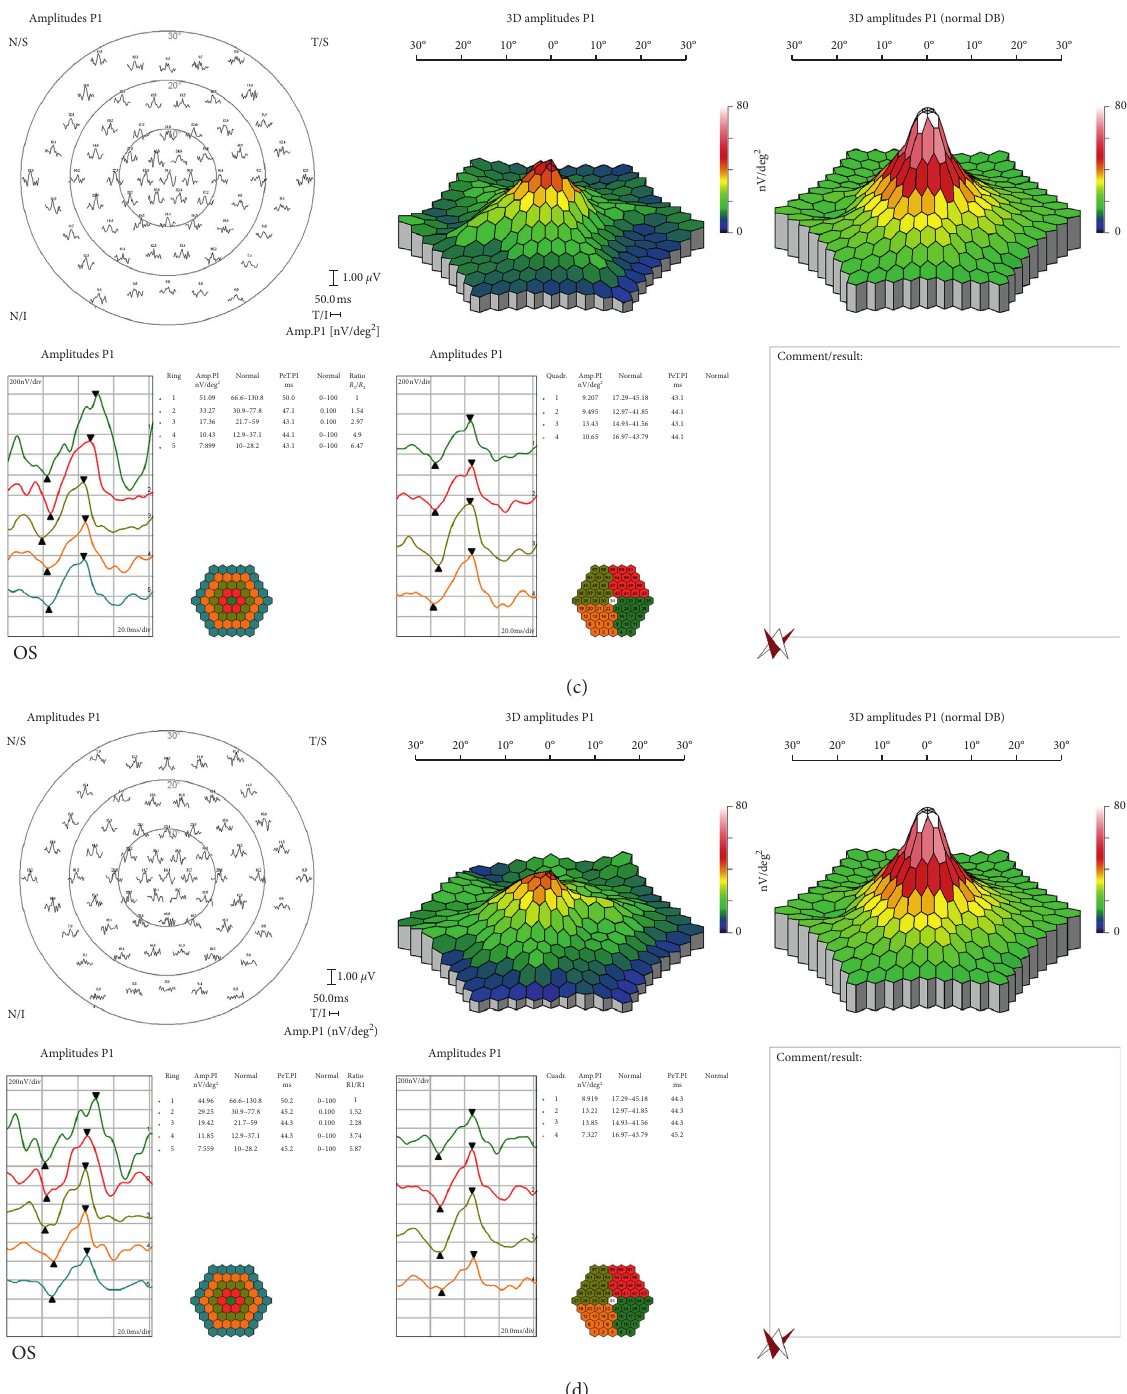
Figure 2: Multifocal electroretinography outcomes: (a) and (b) two students from the control group with normal foveal responses; (c) and (d) two students from the CVS group with reduced foveal